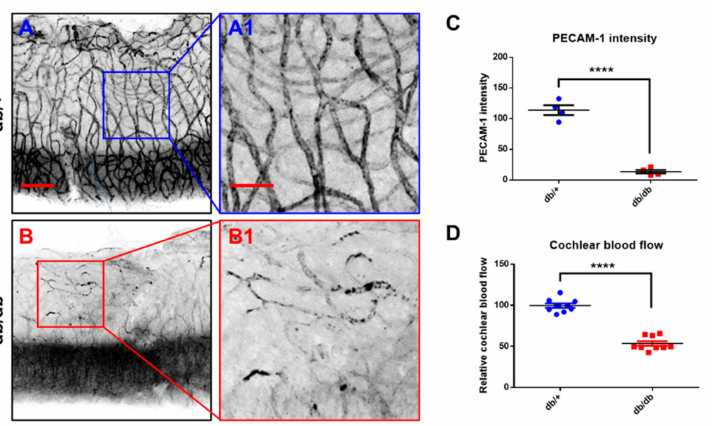
Figure 4. Changes of cochlear blood flow and microvasculature of the stria vascularis. ( A , B ) Im- munofluorescence measurements of platelet endothelial cell adhesion molecule-1 (PECAM-1/CD31) in the vessels of the stria vascularis. Endothelial cells of stria vascularis were stained with anti- PECAM antibody and imaged with a confocal microscope. Scale bar represents 100 µ m ( A , B ) and 40 µ m ( A1 , B1 ). ( C ) Intensity of PECAM-1/CD31 positive area was quantified. PECAM-1/CD31 stain- ing was significantly reduced in db/db mice in the vessels of the stria vascularis. n = 4. ( D ) Cochlear blood flow was significantly decreased in the db/db mice compared to the db/+ animals. n = 9. **** p < 0.0001. Unpaired t